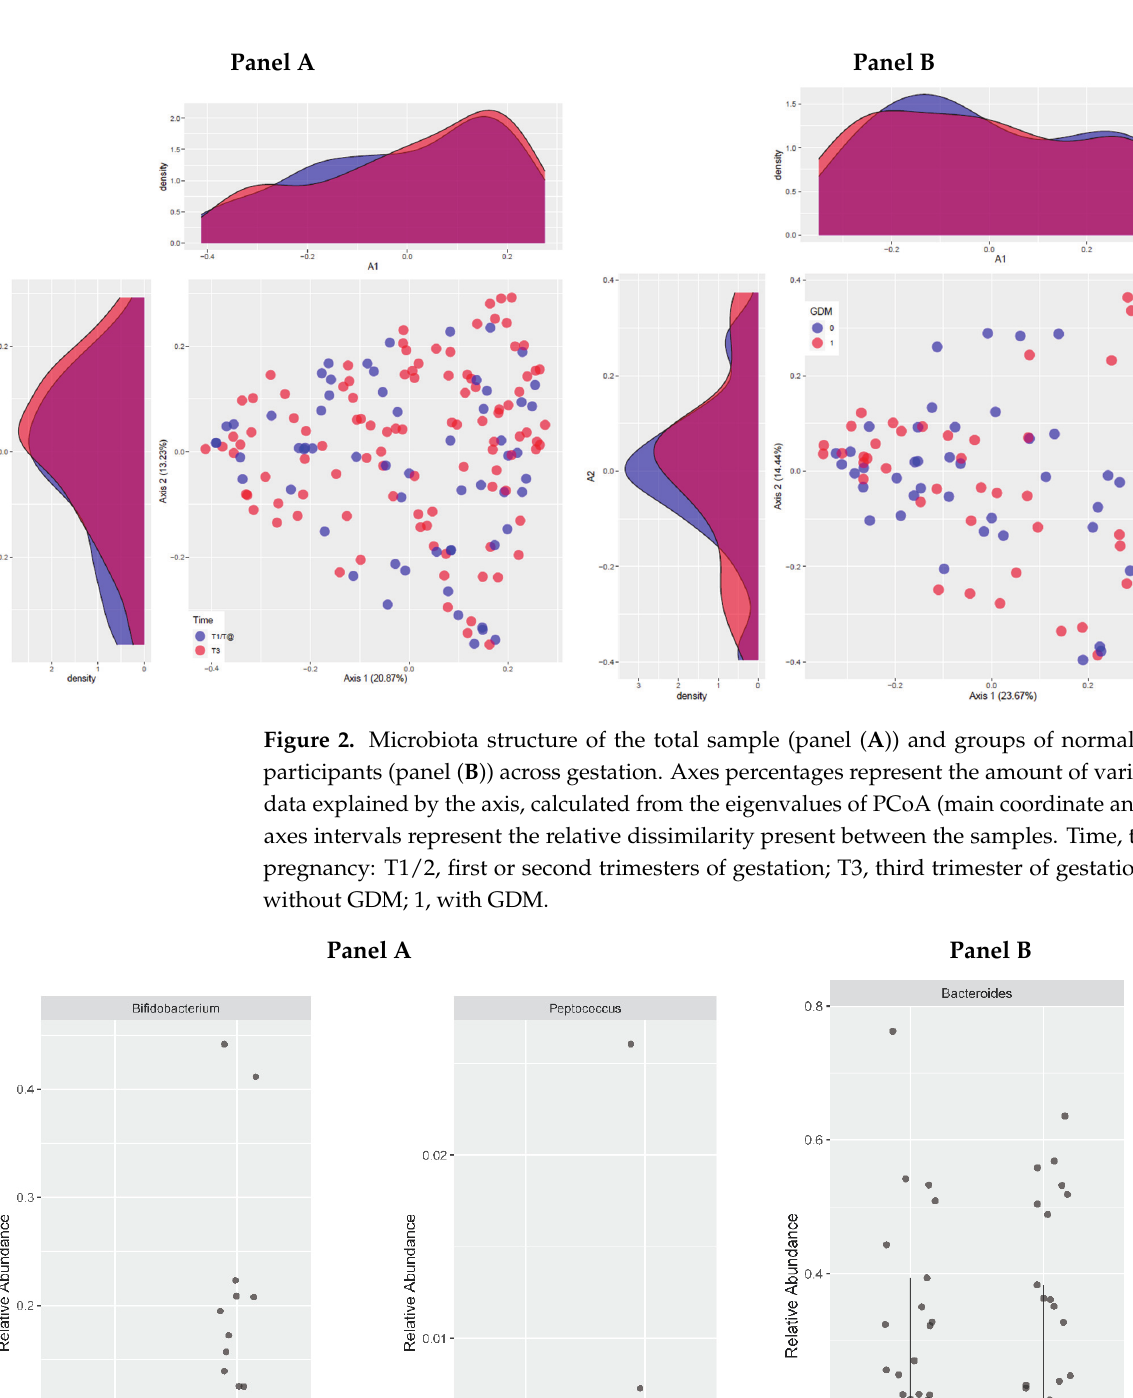
Figure 1. Study flowchart.